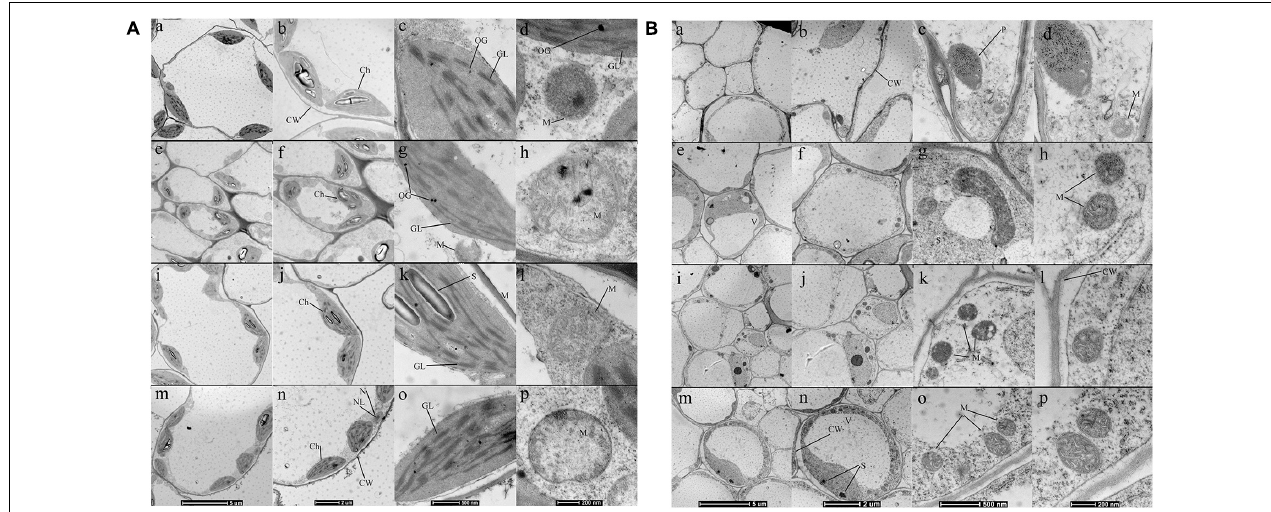
FIGURE 4 | Effects of ALA under Cd stress on the ultrastructural observation of mesophyll cell and chloroplast of cabbage shoots (A) and roots (B) . In (A,B) : (a,e,i,m) ( × 1,900), (b,f,j,n) ( × 2,900), (c,g,k,o) ( × 13,000), (d,h,l,p) ( × 23,000); (a–d) Seedlings grown in normal condition. (e–h) Seedlings sprayed 25 mg/L ALA only. (i–l) 50 µ M CdCl 2 treated seedlings. (m–p) Seedlings simultaneously treated with 50 µ M CdCl 2 and 25 mg/L ALA. The seedlings were treated as in Figure 1 . CW, cell wall; Ch, chloroplast; OG, osmiophilic globules; GL, grana lamella; S, starch; M, mitochondria; N, nucleus; NL, nucleolus; P, plastid; S, starch;